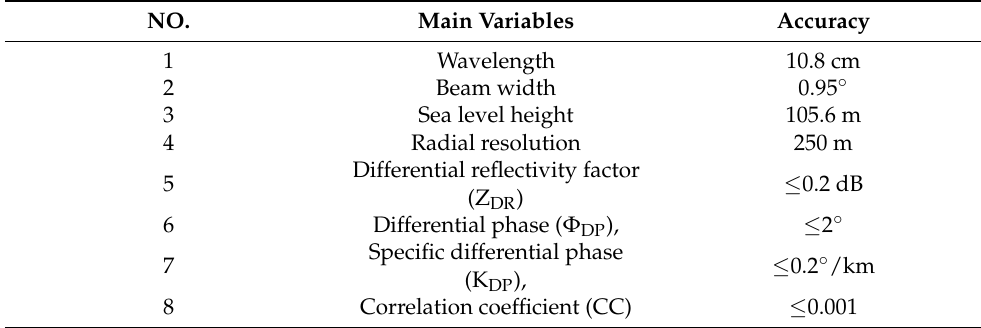
Table 1. Main performance indices of